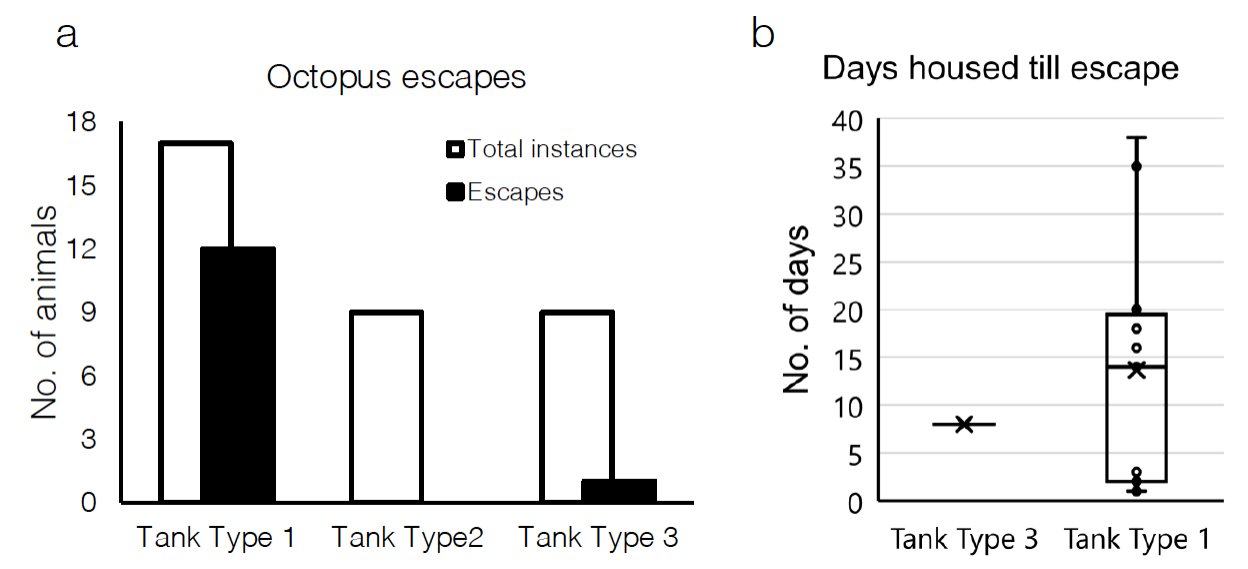
Figure 3. ( a ) The total number of subjects in the different tank types ( n = 35). In total there were 13 octopus escapes. Twelve of the escapes were from Type 1 tanks, and no animals escaped from Type 2 tanks. ( b ) The number of days in tank before escape occurred for Type 1 and Type 3 tanks. There is a statistically significant higher number of escapes from Tank 1 than Tank 3 (n = 26, chi 2 = 8.3268, p = 0.0039). The majority of escapes from Type 1 tanks occurred within the first 20 days (X marks average, 14 in Tank 1, and only one single escape after 8 days in Tank 3).